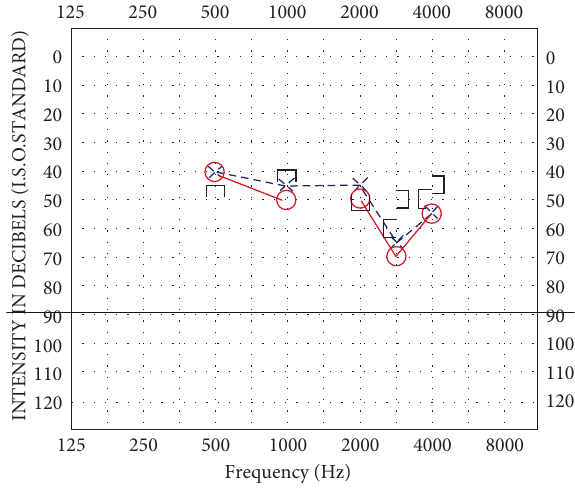
Figure 1: Audiogram pretreatment: bilateral mild sloping to moderate-severe sensorineural hearing